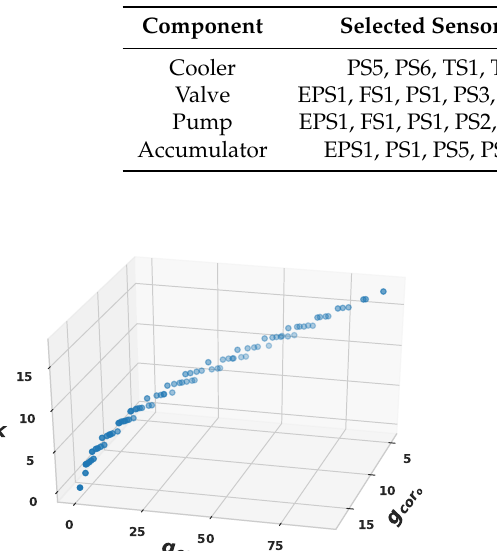
Table 5. Selected features for each fault type.